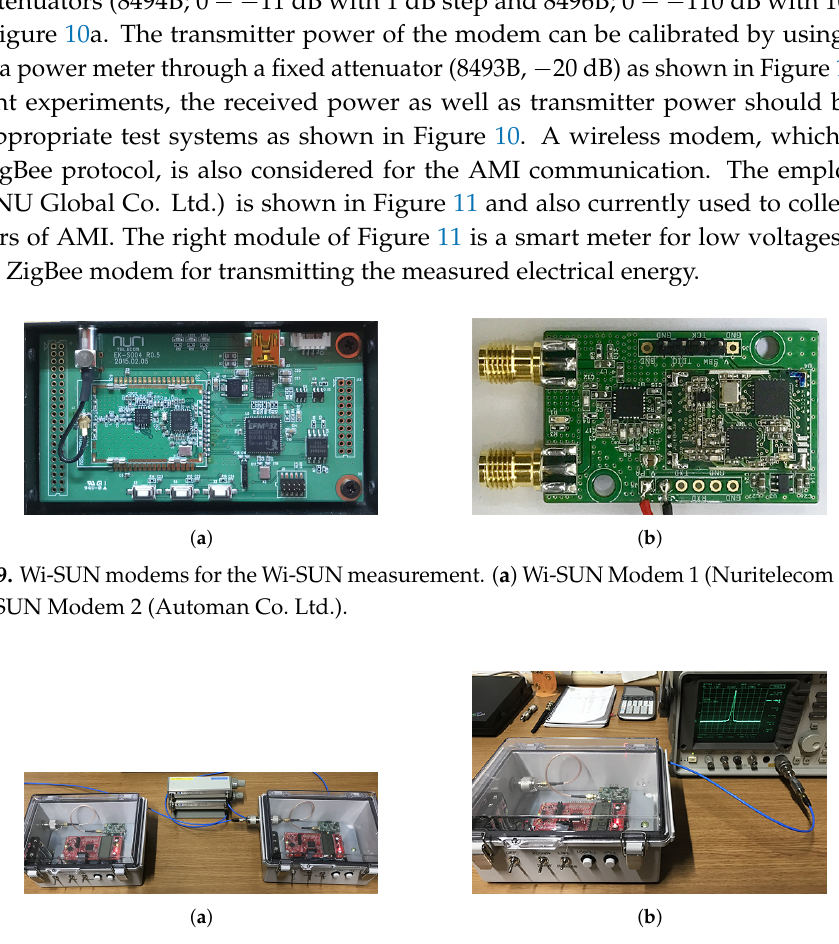
Figure 10. Test system for the wireless smart utility network (Wi-SUN) measurement at line of sight (LOS) based on Wi-SUN Modem 2. ( a ) Measurement of the receiver sensitivity and an Receiver Signal Strength Indication (RSSI) calibration. Fixed and step attenuators (8493B, 8494B, and 8496B of Keysight) are placed between test systems that are respectively used as master and slave parts. ( b ) Transmitter power calibration with a spectrum